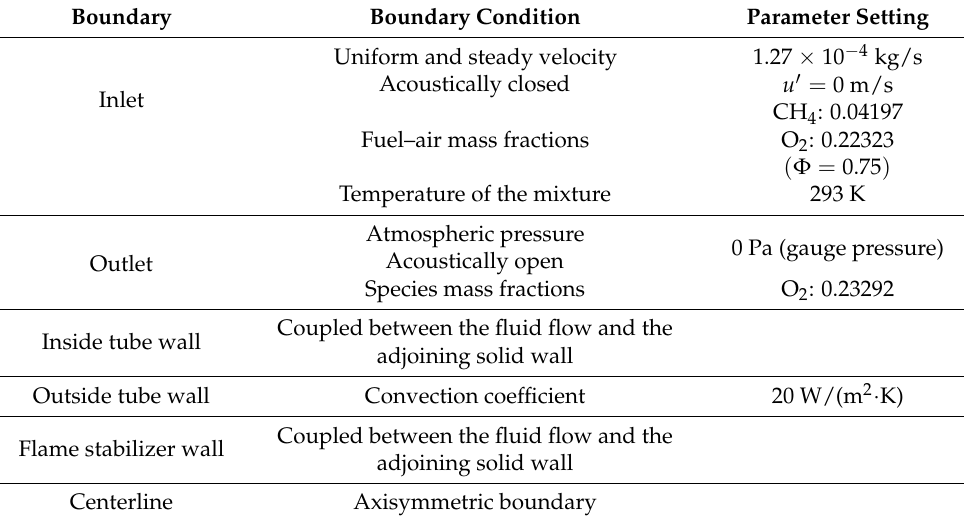
Table A1. Operational conditions for the Rijke burner simulation.